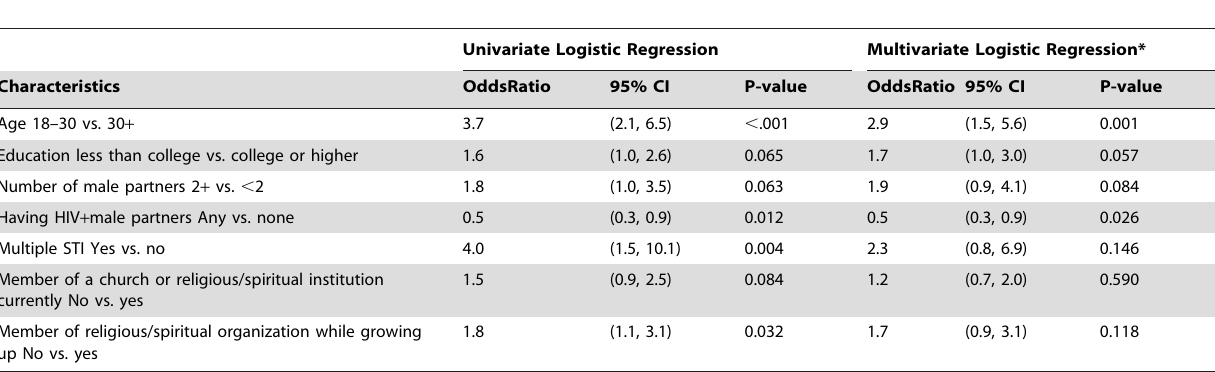
Table 5. Univariate and multivariate logistic regression on modeling the probability of Black men who have sex with men being newly diagnosed HIV infection (NHIV) versus previously diagnosed HIV infection (PHIV) at time of enrollment.